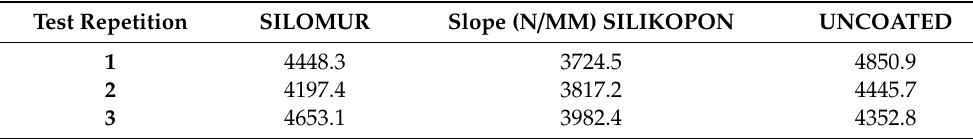
Table 1. FIMEC slope before